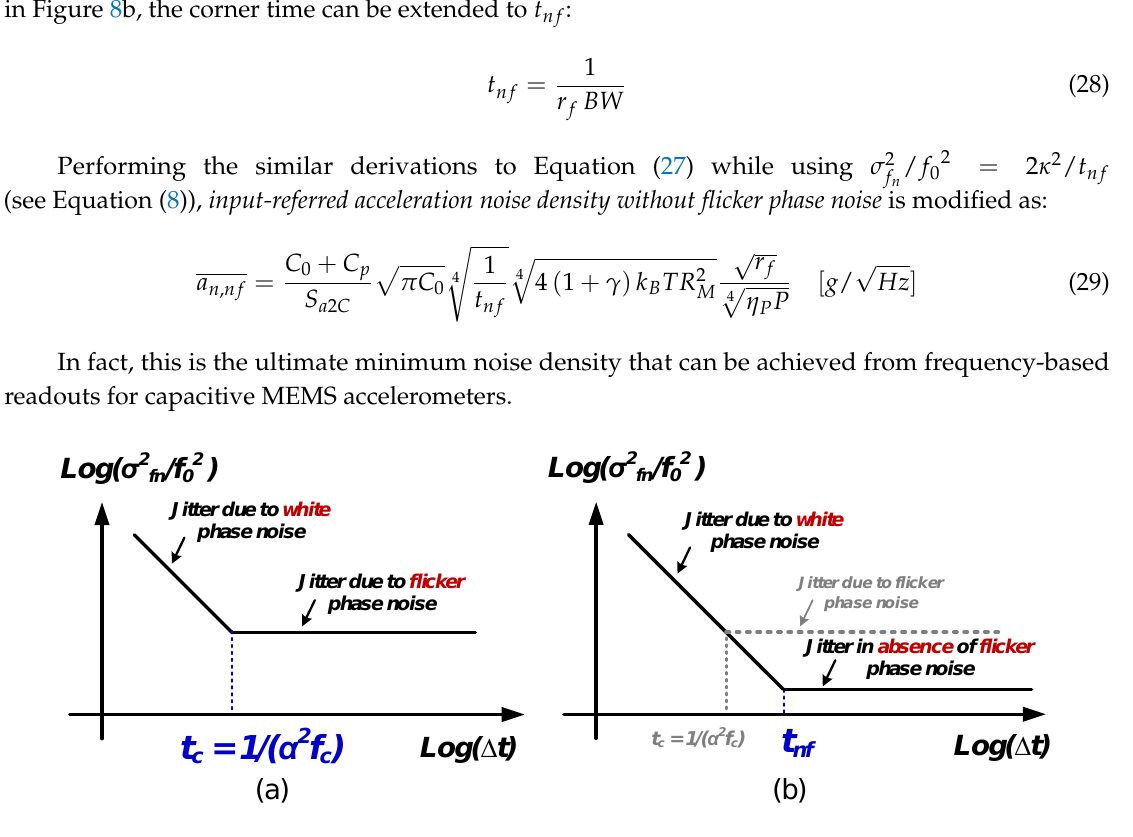
Figure 8. ( a ) averaging and flattening characteristic of frequency resolution ( σ 2 of measurement time ∆ t , where the corner time t c is 1/ to t nf without flicker phase